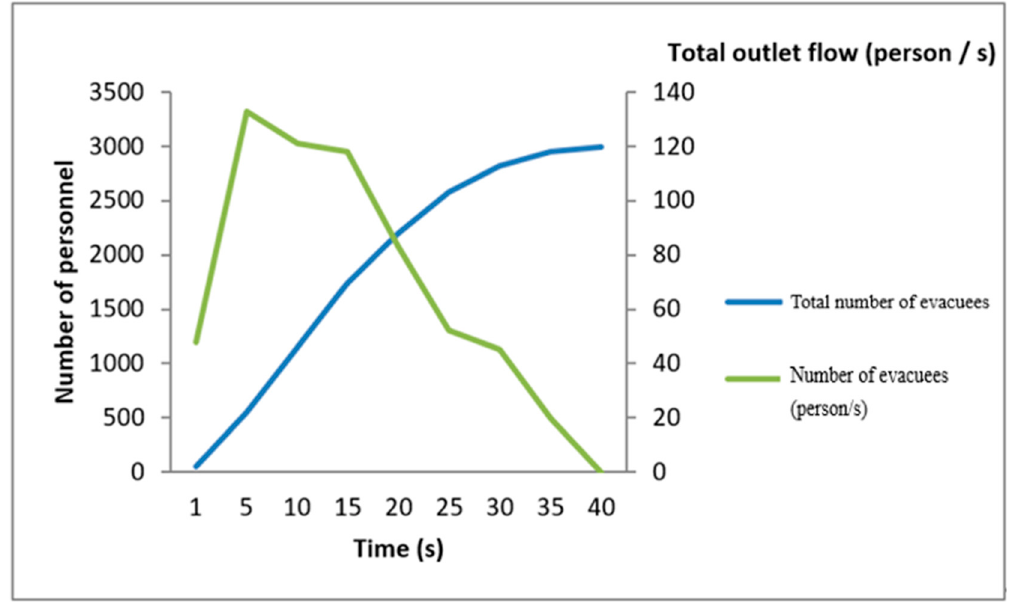
Figure 25. Relationship between evacuation number and time.